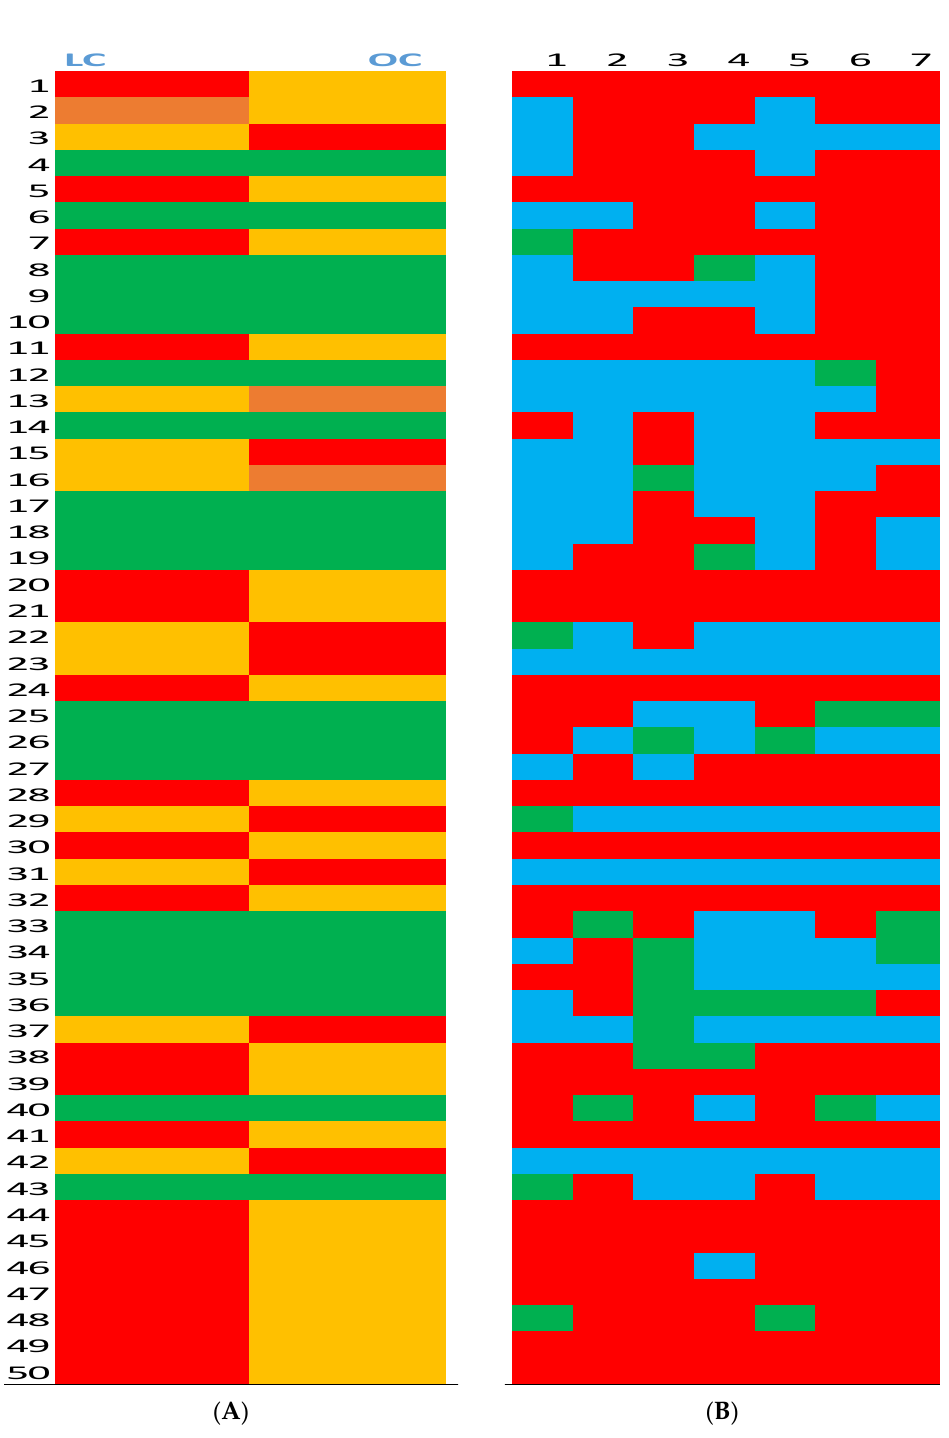
Figure 1. Average peak heights in serum from lean (L) and obese (O) Zucker rats (Panel A ) and serum peak height ratios in lean (L) and obese (O) Zucker rats (Panel B ). (Panel A ): Average height of the corresponding 50 peaks was compared between L and O groups. Significantly ( p > 0.05) higher average peak intensity in the group. Significantly ( p > 0.05) lower average peak intensity in the group. No difference between groups. Marginal (0.1 < p > 0.05) difference between groups. (Panel B ): Pairs of 50 peaks intensity ratio between L and O groups. Peak ratio at least 50% higher in the L group. Peak ratio at least 50% higher in the O group. No difference between groups.